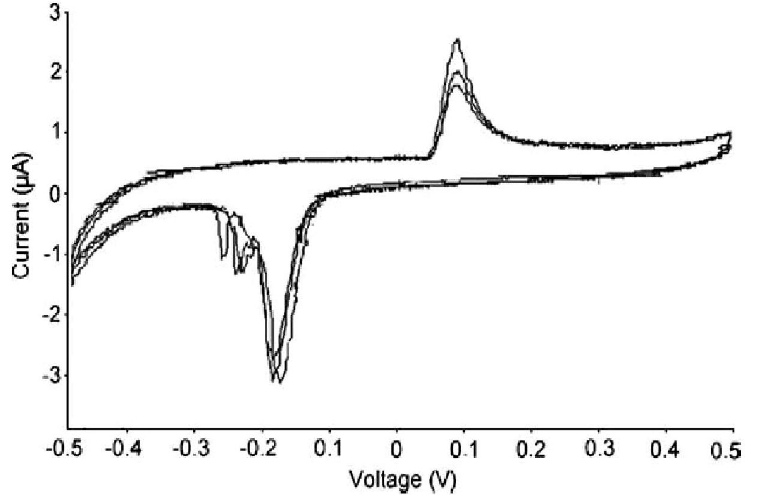
Figure 2. Cyclic voltammograms (CV), showing the I–V current-voltage curves of s.p.e. of APA–P450scc Electrode in presence of substrate LDL-cholesterol. The s.p.e.